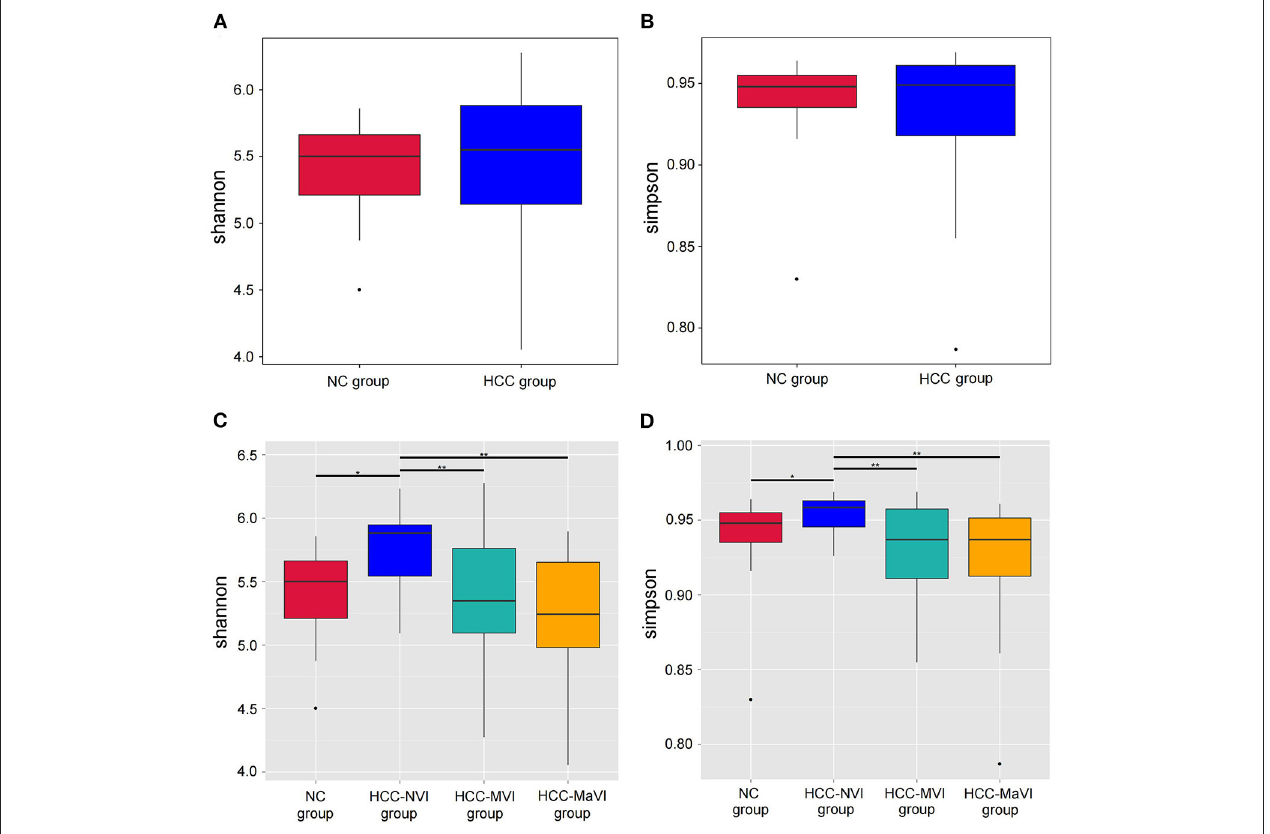
FIGURE 2 | Comparison of alpha-diversity of the gut microbiota between patients with HCC and the NC group. Shannon (A) and Simpson (B) indexes were used to evaluate the evenness and richness in the HCC and NC groups; Shannon (C) and Simpson (D) indexes were used for comparing the evenness and richness in the NC, HCC-NVI, HCC-MVI, and HCC-MaVI groups. Difference in microbiota composition between the groups based on Bray-Curtis metrics was displayed by box-plot according to the Wilcoxon rank-sum test, * P < 0.05, ** P <